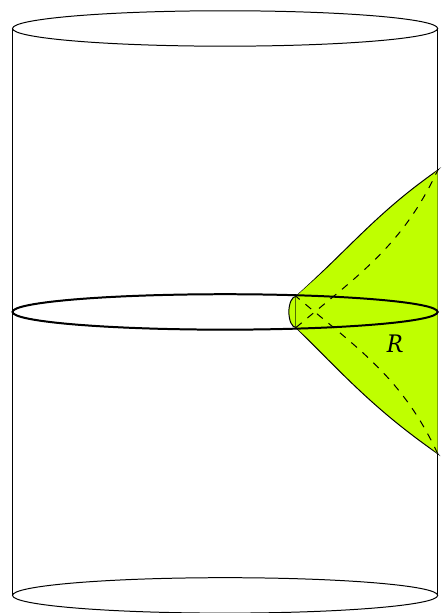
Figure 6: Causal Wedge of a boundary region